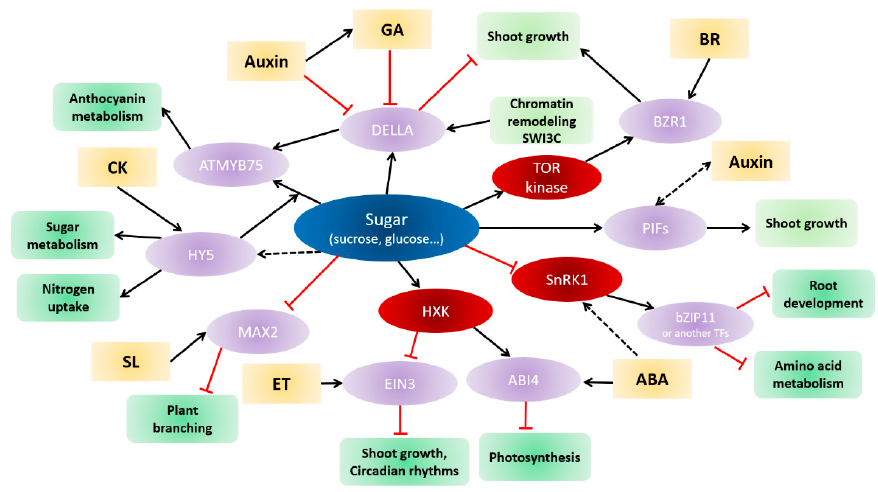
Figure 2. Schematic representation of the crosstalk between the sugar and hormone signaling pathways (orange frame) in the regulation of certain physiological processes (green frame). Light-purple circles represent hub regulators, including transcription factors (ABI4: ABA insensitive 4; ATMYB75/PAP1; bZIP11; EIN3: ETHYLENE-INSENSITIVE 3; HY5: Elongated Hypocotyl 5: PIFs: Phytochrome interacting factors), F-box (MAX2: MORE AXILLARY 2) and key regulators of the hormone signaling pathways (DELLA and BZR1: BRASSINAZOLE RESISTANT). Red circles represent glucose sensors (HXK: hexokinase) and energy sensors (SnRK1: Sucrose non-fermenting related kinase 1; TOR-kinase: Target of Rapamycin kinase). ABA: Abscisic acid; BR: Brassinosteroid; CK: Cytokinin; GA: Gibberellin; SL: Strigolactone. Black arrows indicate stimulating effects and red blunts indicate repressing effects.